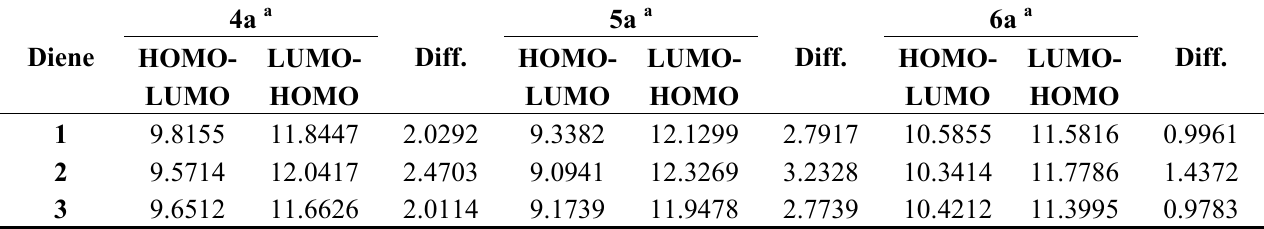
Table 5. Energy gaps (eV) of the frontier molecular orbitals for dienes 1 – 3 and dienophiles 4a – 6a